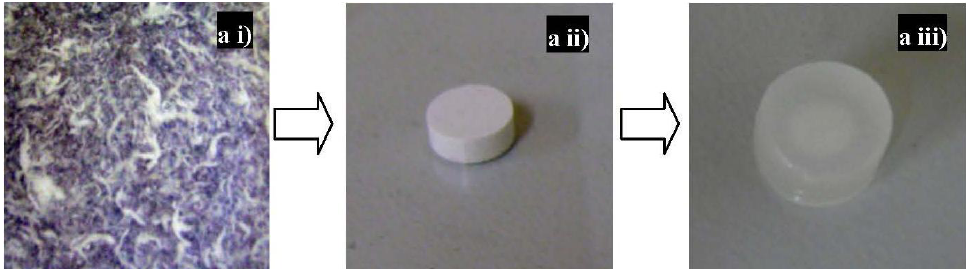
Figure 11. Digital images of ( a ) transition of IPEC from ( i ) synthesis to ( ii ) compression into tablet matrix and ( iii ) in vitro drug release retaining its three dimensional network; ( b ) NaCMC after ( i ) compression into tablet matrix and ( ii ) in vitro drug release losing its three dimensional